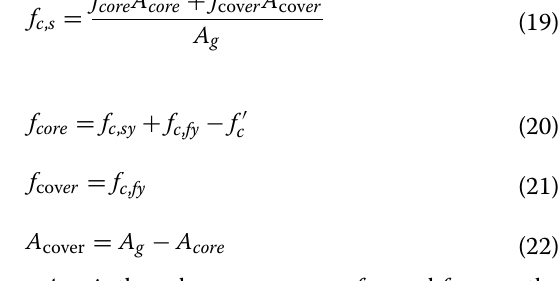
0.003 and b ρ f = =